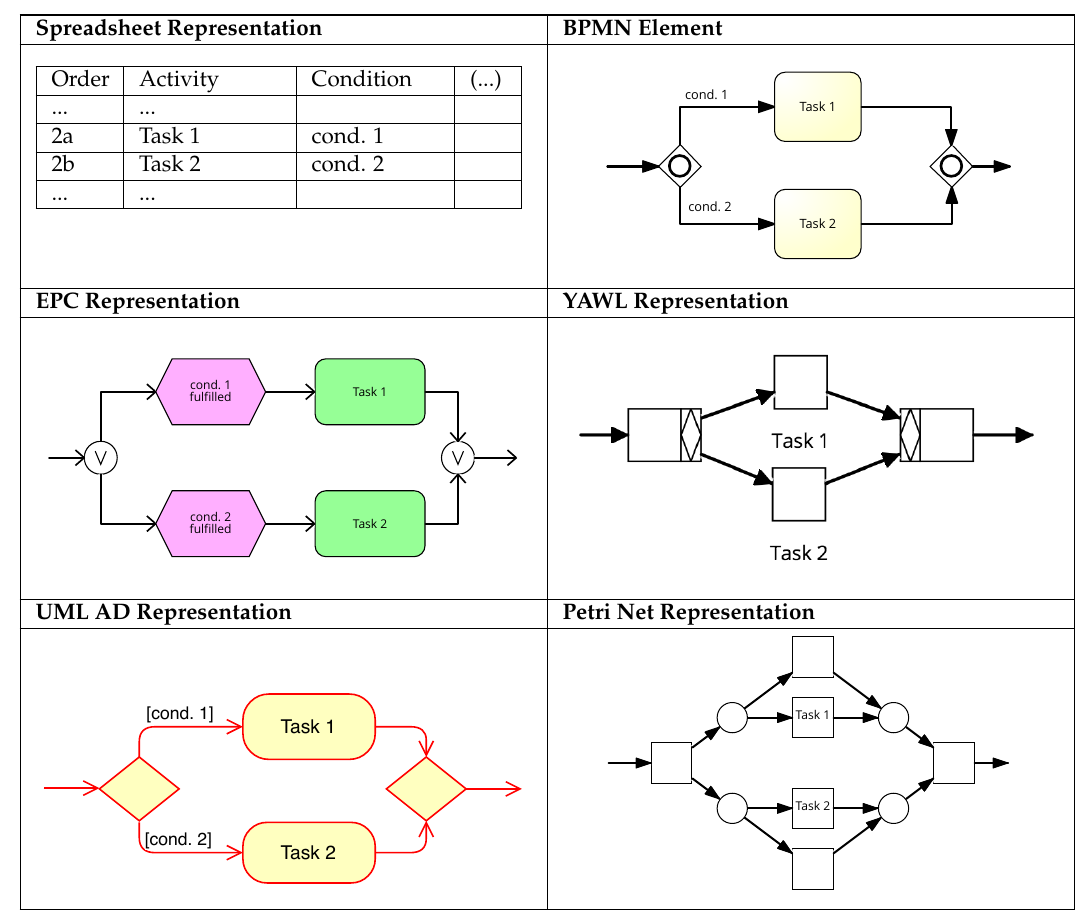
Table 11. OR-gateway